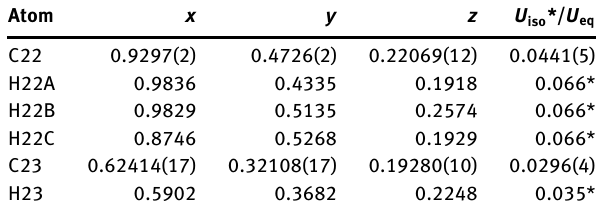
Table 2: Fractional atomic coordinates and isotropic or equivalent isotropic displacement parameters (Å 2